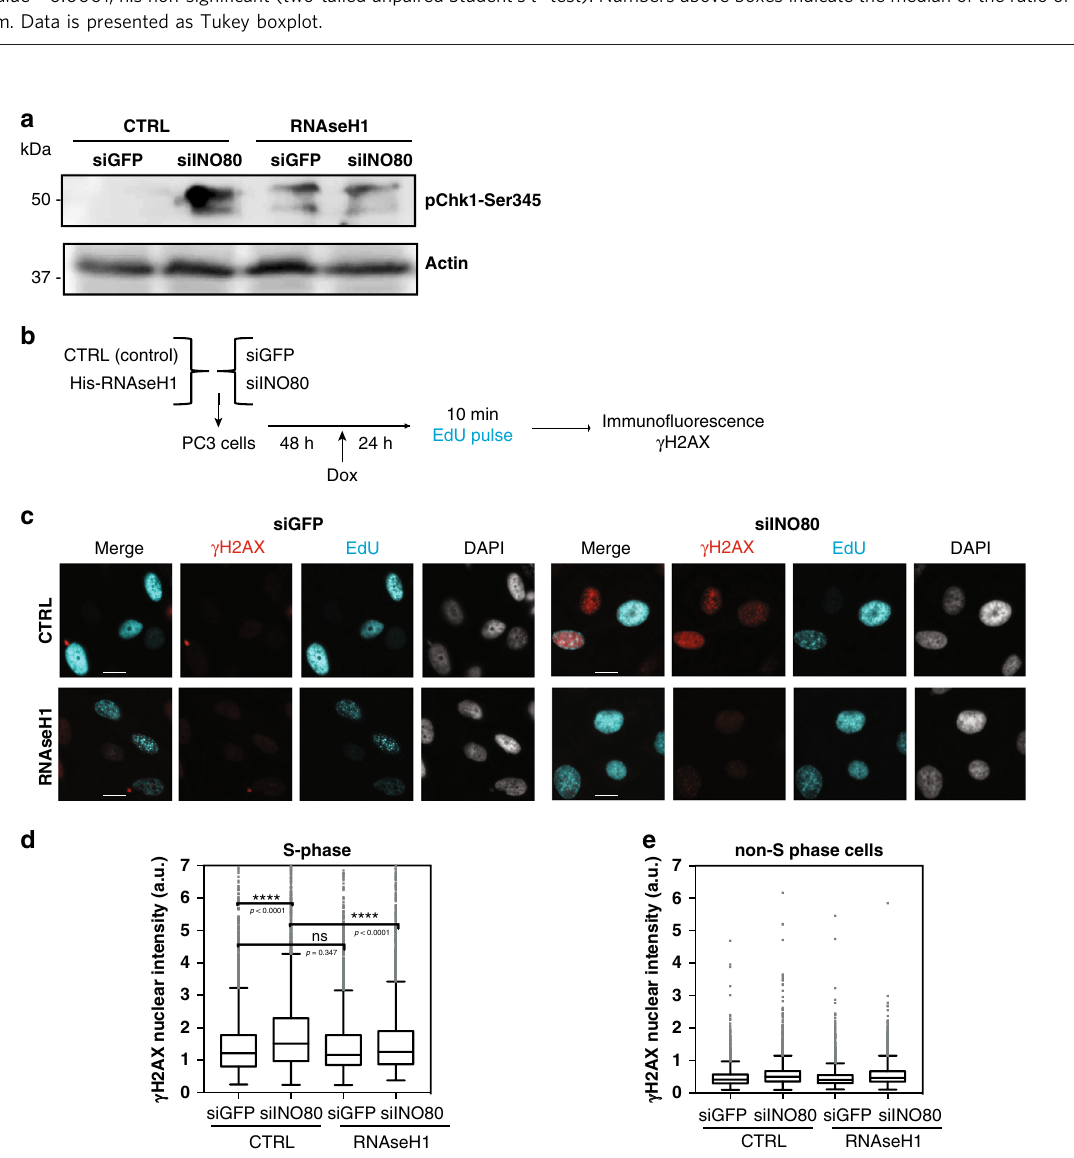
Fig. 3 Replication stress-induced DNA damage in INO80-de fi cient cells is caused by R-loops. a PC3 cells were transfected with control vector (CTRL) and either esiRNA against GFP (lane 1) or INO80 (lane 2) or transfected with RNAse H1-expressing plasmid (RNAseH1) and esiRNA against GFP (lane 3) or INO80 (lane 4). Forty-eight hours later cells were induced with doxycycline and 24 h later analyzed by Western with an antibody against pChk1-Ser345. Similar results were obtained in two independent experiments. b Schematic representation of the experimental setup used. PC3 cells were co-transfected with esiRNAs against either GFP (siGFP) or INO80 (siINO80) along with either a control (CTRL) or RNAse H1-overexpressing (RNAseH1) vector. Two days later RNase H1 overexpression was induced by doxycycline for 24 h. To distinguish cells in S-phase, cells were labelled with 25 µ M EdU, fi xed and stained with an antibody against γ H2AX and “ clicked ” with Alexa Fluor 488 azide. c Representative images of cells as in b . Scale bar 10 µ m d Distribution of nuclear γ H2AX staining intensities in S-phase cells; **** p -value < 0.0001, ns nonsigni fi cant (two-tailed unpaired Student ’ s t -test). At least 500 cells were measured per condition in each of three independent experiments. Data is presented as Tukey boxplot. e Distribution of nuclear γ H2AX staining intensities in non-S-phase cells. Data in d , e are from three independent experiments following normalization (to median intensity of entire population of siGFP/CTRL sample in each experiment). Tukey boxplot is used. Source data are provided as a Source data fi